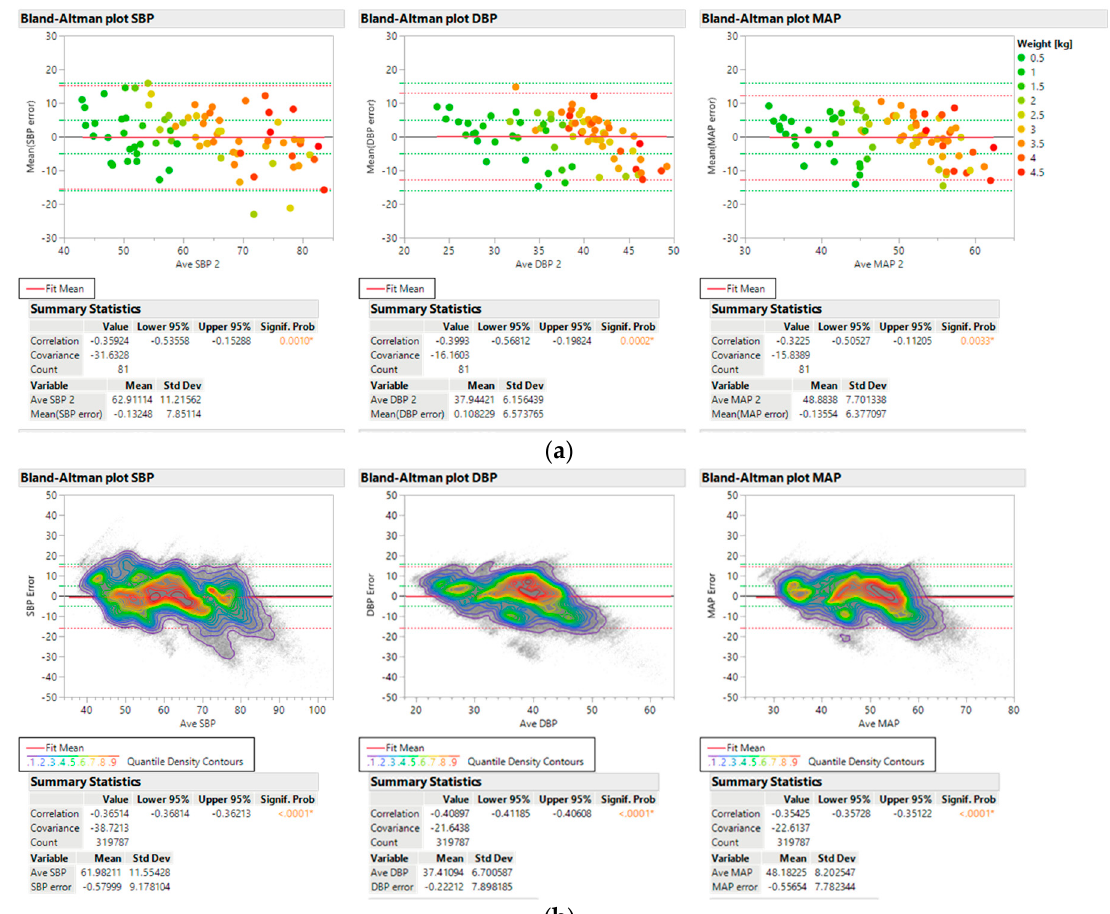
Figure 3. Bland–Altman plots for SBP, DBP, and MAP: ( a ) values averaged over each individual for 81 test patients; and ( b ) all data values without averaging. Bland–Altman plots represent a scatter plot of average versus difference of BP readings constructed for SBP, DBP, and MAP. Points are color coded by patient weight. Red dotted lines indicate 2 * SD of the calculated values. Green dotted lines indicate targets based on FDA guidelines for accuracy of MAE ≤ 5 mmHg and 2 * SD ≤ 2 * 8 mmHg. The figures were generated using JMP software version 16.2.0.